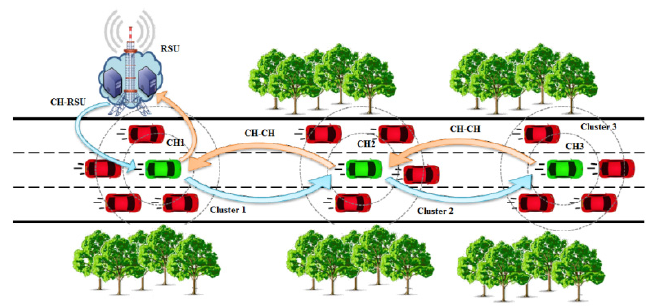
Figure 3. Cluster-based VANETs.